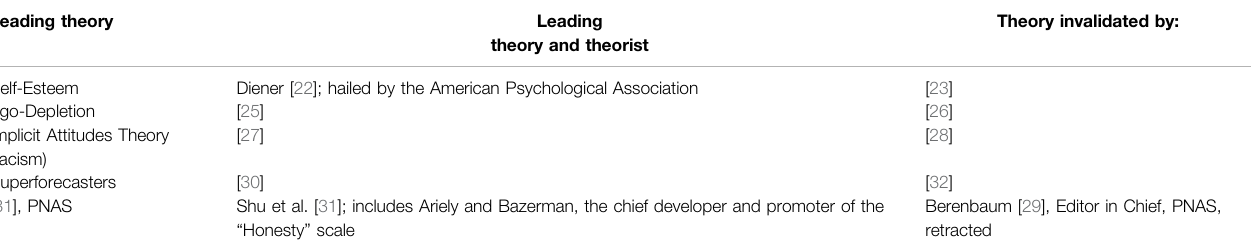
TABLE 1 | The failure of concepts to generalize to build new theory: The case of social science in closed systems. Column two contrasts the leading concepts in social science by its founding social scientist(s); Column three shows the scientist who toppled the leading concept. The table highlights the inability of social scientists tobuild new theory from prior fi